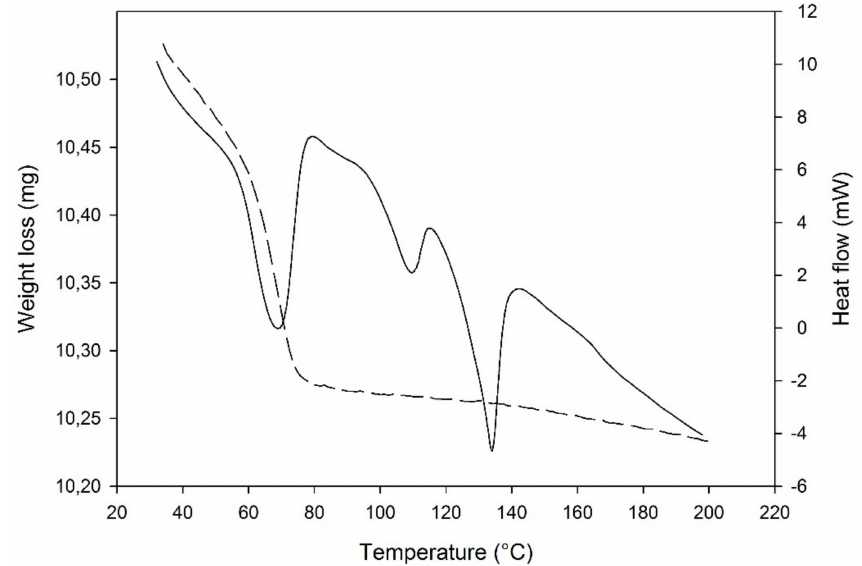
Figure 6. DSC-TGA traces of PZQ-HH (solid lines refer to DSC